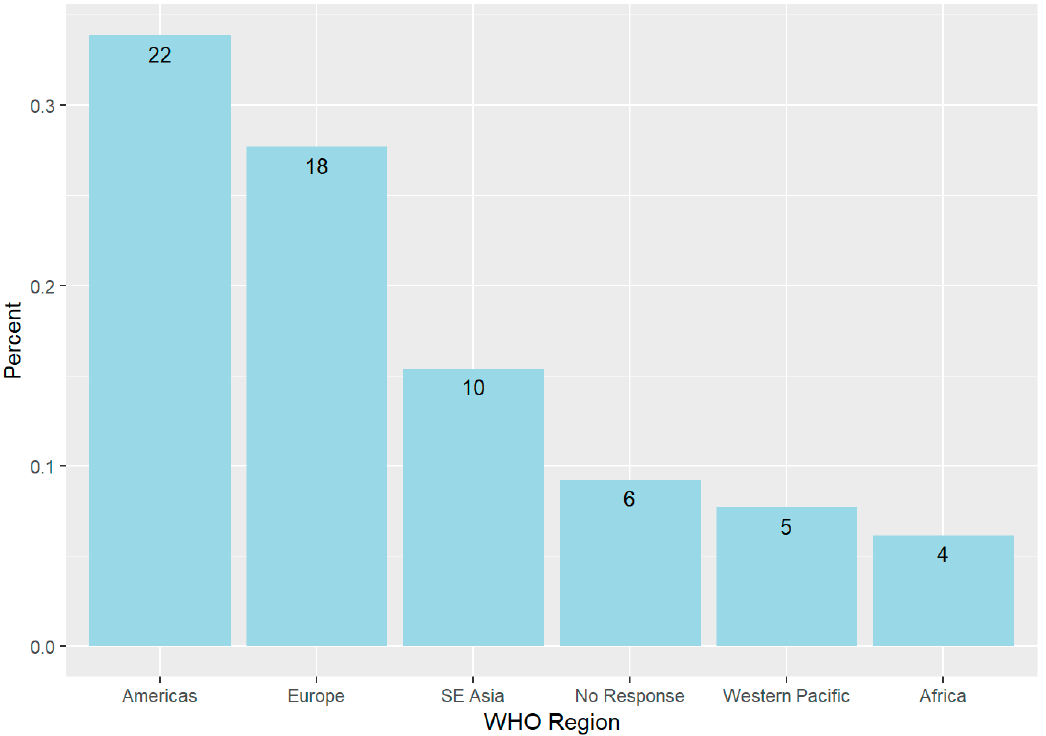
Figure 1. WHO Regions Represented by Framework Convention Alliance Survey Participants, 2019.